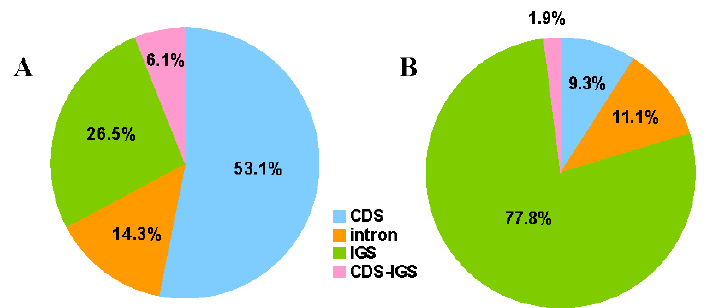
Figure 3. Distribution of repeat sequence and simple sequence repeats (SSRs) within F. suspensa chloroplast genomes. ( A ) Distribution of repeats; and ( B ) distribution of SSRs. IGS: intergenic spacer. Table 5. Distribution of SSR loci in the chloroplast genome of Forsythia suspensa